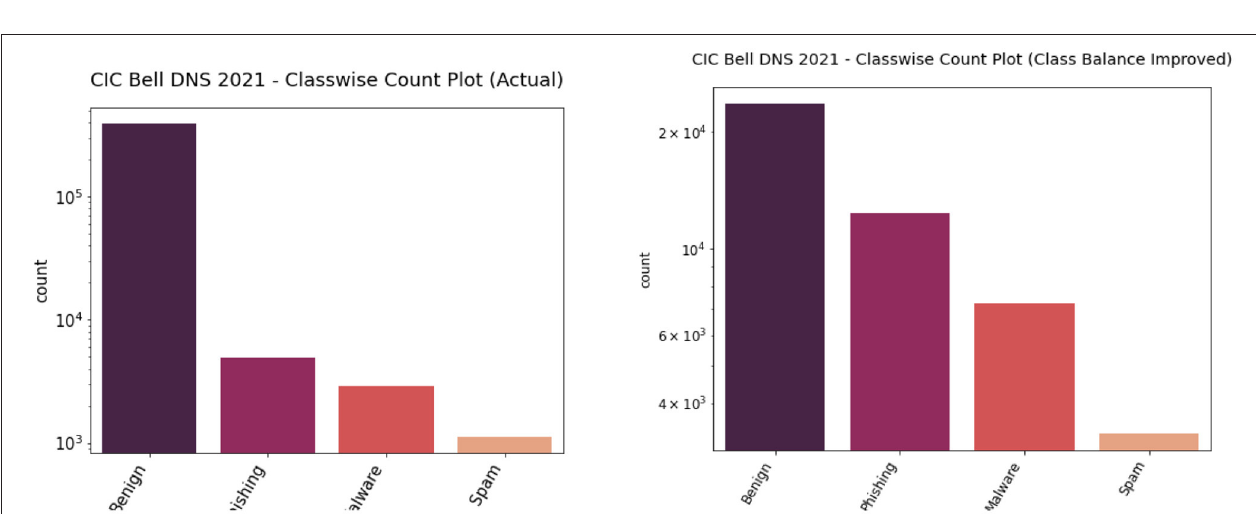
FIGURE 7 | Binary class count plot of actual (left) and class balance improved (right) CIC Bell DNS 2021 dataset.